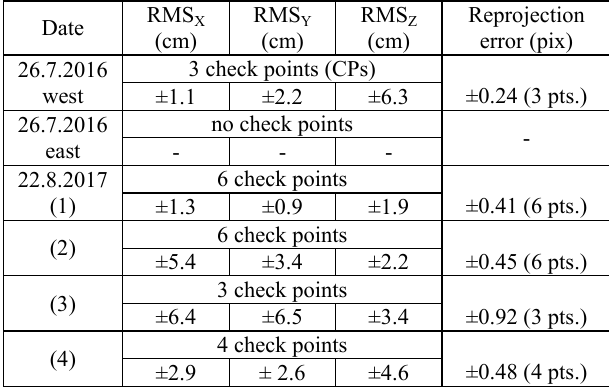
Table 5. Statistics of the bundle block adjustments (part 2)